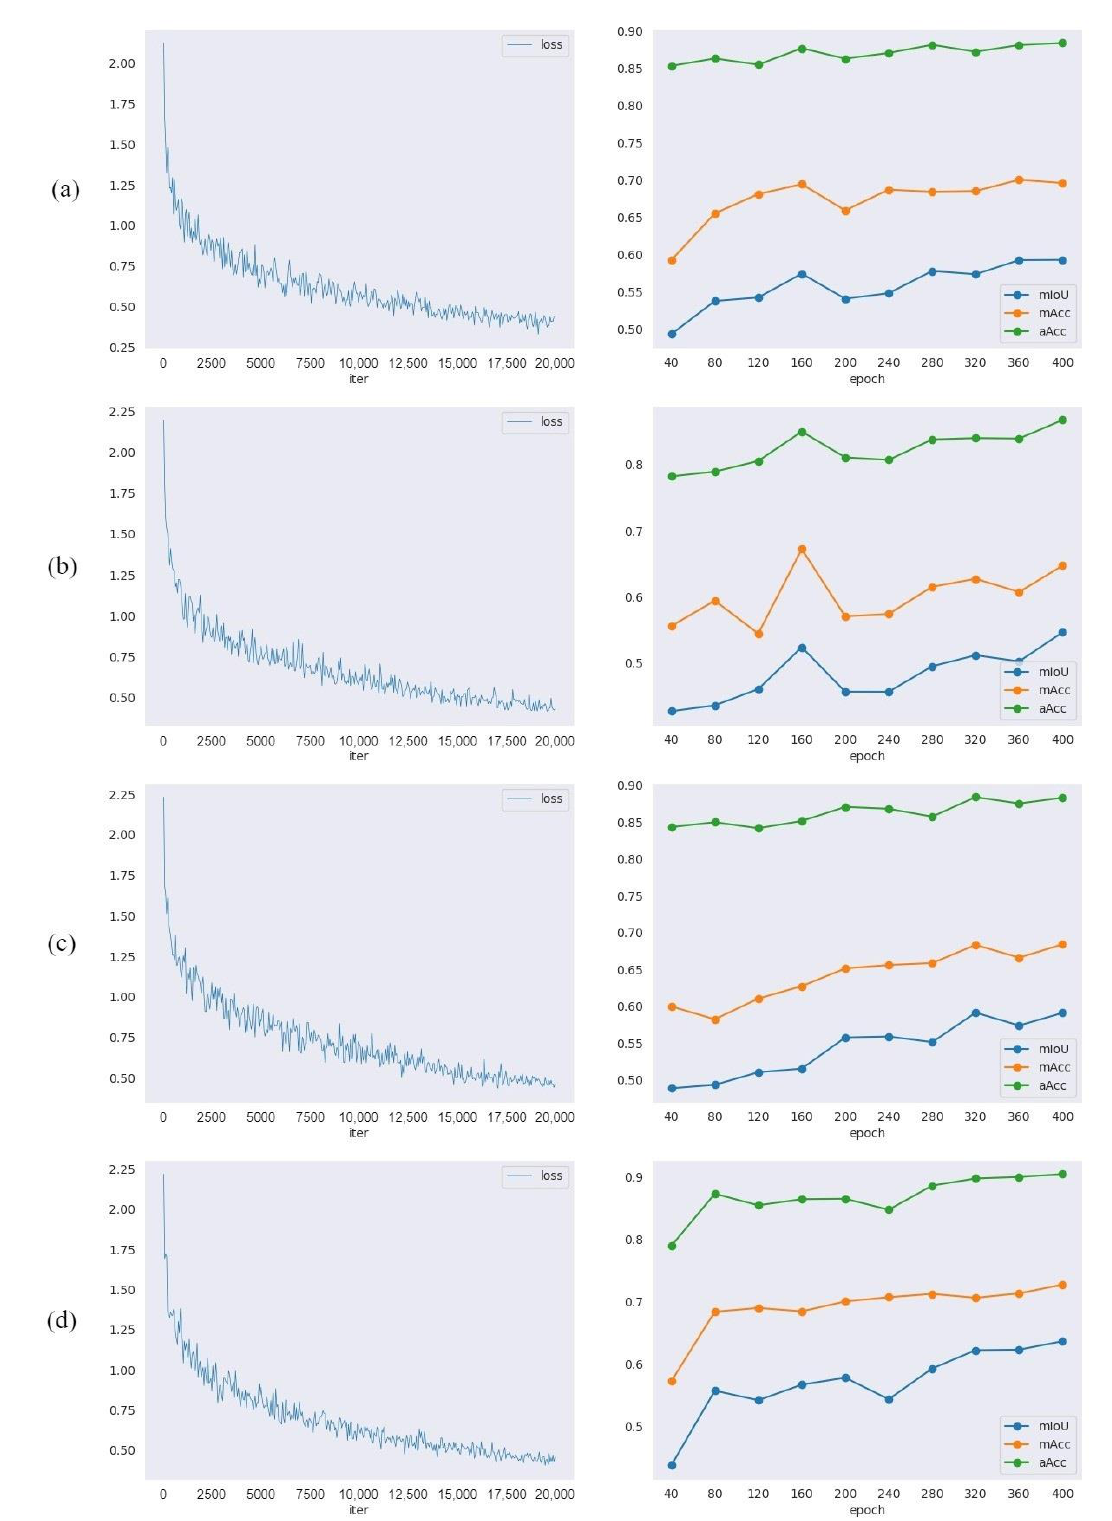
Figure 11. Loss and metrics curves for ( a ) FCN, ( b ) PSANet, ( c ) ANNN, and ( d ) PALESNet. It can be seen that compared to the original FCN, the attention-based methods could continually learn information from the training and resulted in the upward trend on all evaluation metrics. Moreover, the proposed PALESNet had a smoother convergence curve than PSANet and had a higher convergence speed compared to ANNN.